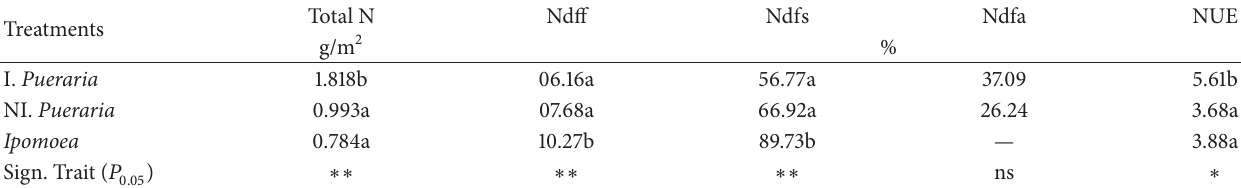
Table 2: N status in plants (inoculated and noninoculated Pueraria , Ipomoea ) at harvest. Total N Treatments